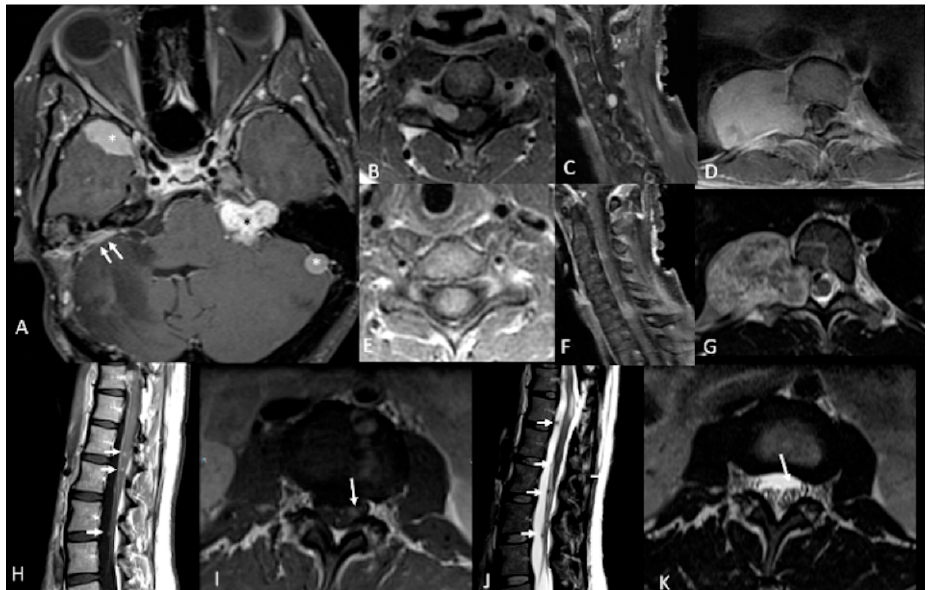
Figure 1. 46-year-old woman with neurofibromatosis type 2 (NF2). Contrast-enhanced T1-weighted-Fat saturation MR images ( A , F , I ) show avidly enhancing schwannoma involving left cerebellopontine angle and internal auditory canal (black asterisk in ( A )) and avidly enhancing meningiomas in the right anterior temporal convexity, sphenoid wing, and left lateral posterior fossa (white asterisks in ( A )). Post-operative changes from right suboccipital craniotomy and mastoidectomy with residual meningioma (white arrows in ( A )). Avidly enhancing dumbbell-shaped right C5 intradural schwannoma extending through right C5 foramen ( B , C ). Large avidly enhancing right paraspinal T10 schwannoma extending through right T10 foramen ( D ) with associated heterogenous T2 hyperintensity on axial T2-weighted image ( G ). Avidly enhancing intramedullary C6 ependymoma ( E , F ). Numerous multilevel tiny enhancing rounded nodules along the cauda equina ( H , I ) consistent with schwannomas which demonstrate T2 hypointensity on axial and sagittal T2-weighted images (white arrows in ( J , K )).